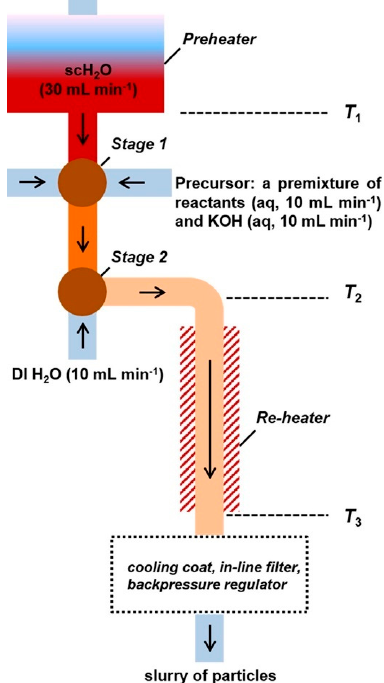
Figure 18. A schematic representation of the two-stage continuous hydrothermal flow synthesis reactor used by Xu et al. for the preparation of Gd-CeO 2 using pressure controlled at 26 MPa. The flow rate of each H 2 O/solution stream is given in parentheses; arrows indicate the flow direction [148]. Reproduced with permission from John Wiley and sons.